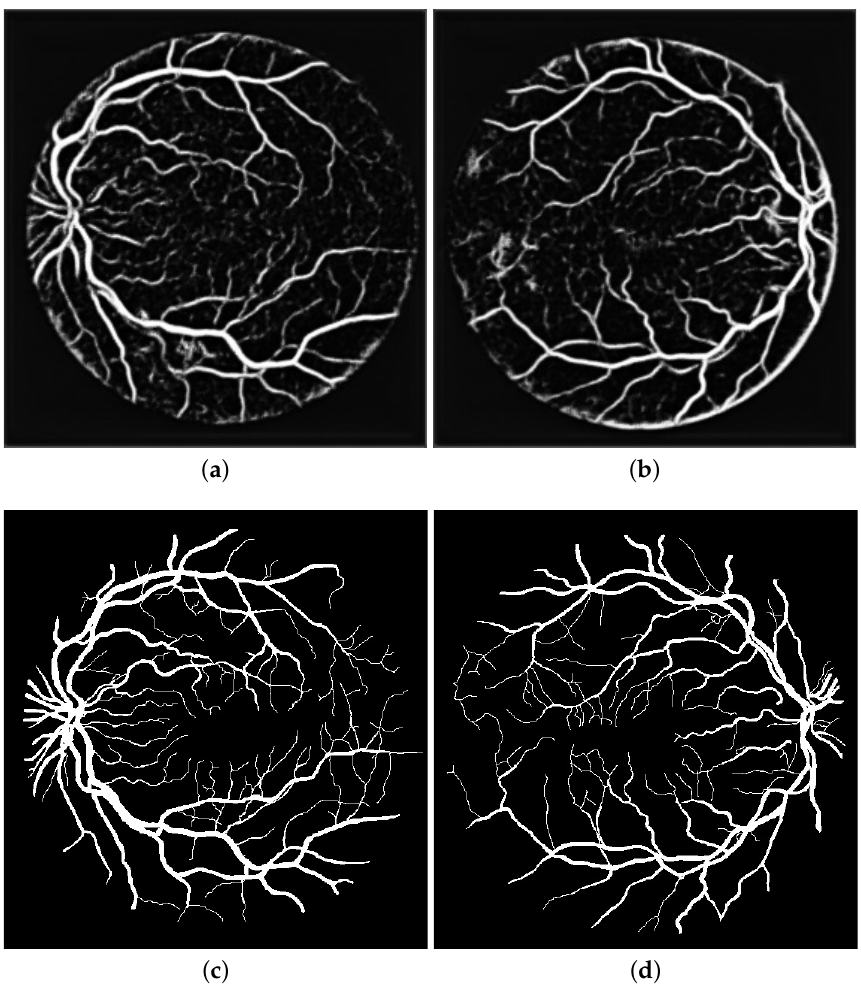
Figure 10. Analysis of vessels observation of pathological images. Fig ( a ) and Fig ( b ) represent the final vessel images of our proposed method. Fig ( c ) and Fig ( d ) represent ground truth